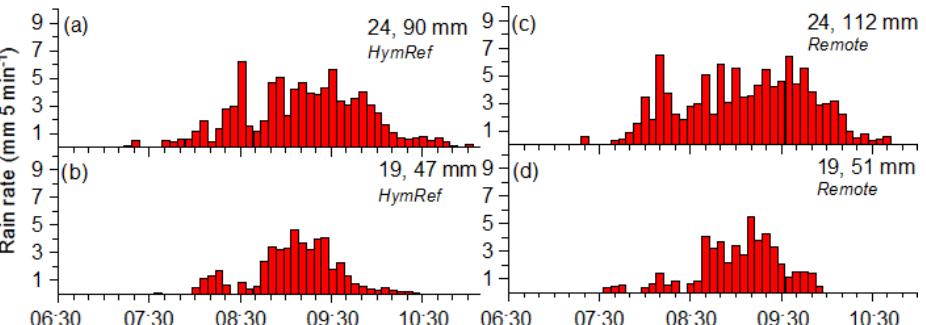
Figure 11. Time evolution of the simulated 5 min rain rates of IOP7a for scenarios HymRef (a, b) and Remote (c, d) . Model results were taken for rain gauge locations 19 and 24 displayed in Fig. 3.